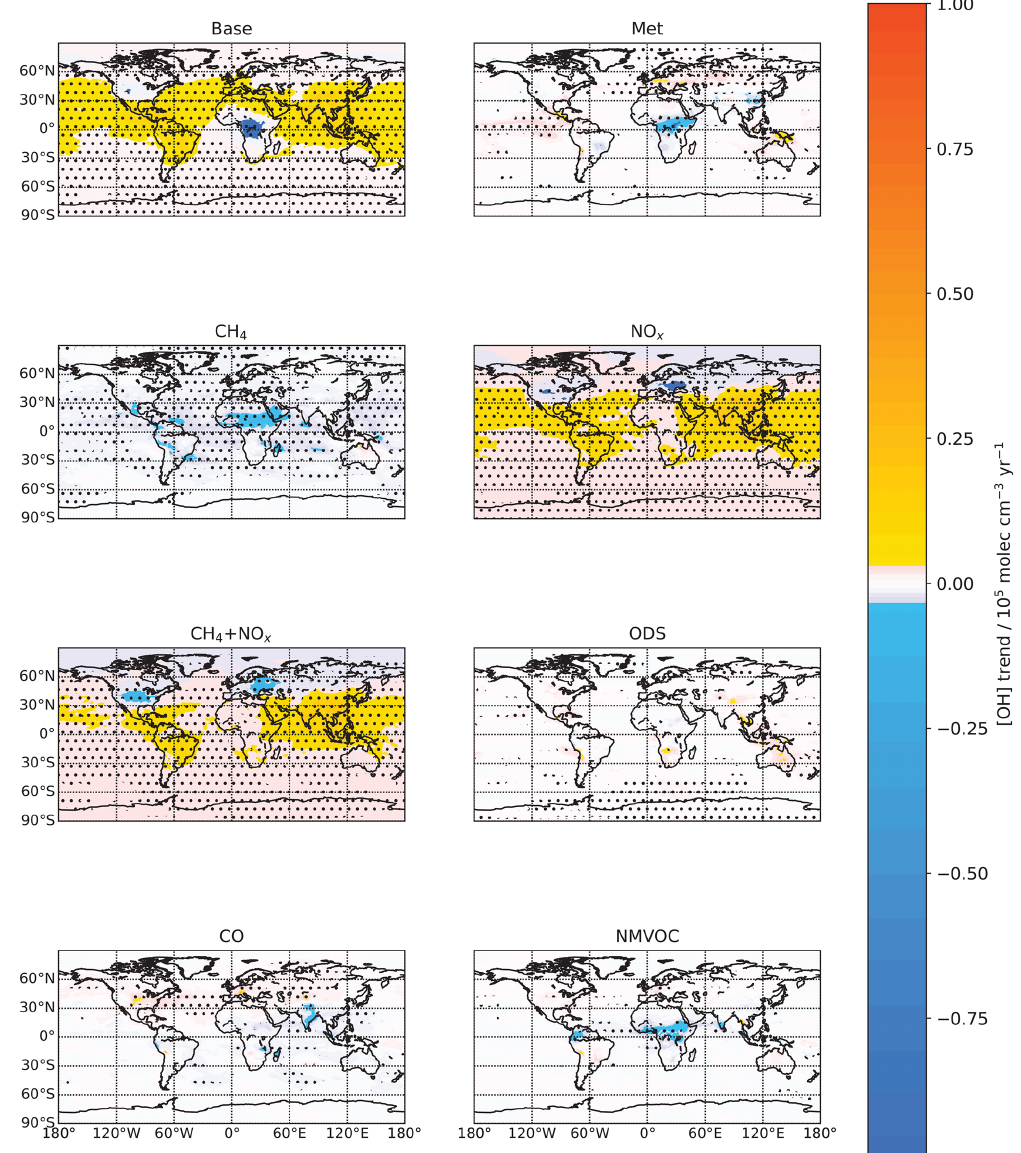
Figure 3. Trends in tropospheric air-mass-weighted OH concentrations by grid box from 1980 to 2014 for the different model runs. Trends are calculated using the Theil–Sen method. Stipples show areas where a significant trend is detected at the 95% level using the Mann– Kendall test. In the Base run, the tropospheric air-mass-weighted column mean [OH] increases over most areas, with the largest increases over much of tropical Asia and China. These increases are also largely driven by the combined effects of non-lightning NO x emissions and CH 4 concentrations. On the other hand, there are also areas, such as over the USA and some parts of western Europe and northern Russia, where there is a small decreasing trend, and there are areas over central Africa that see a pronounced decreasing